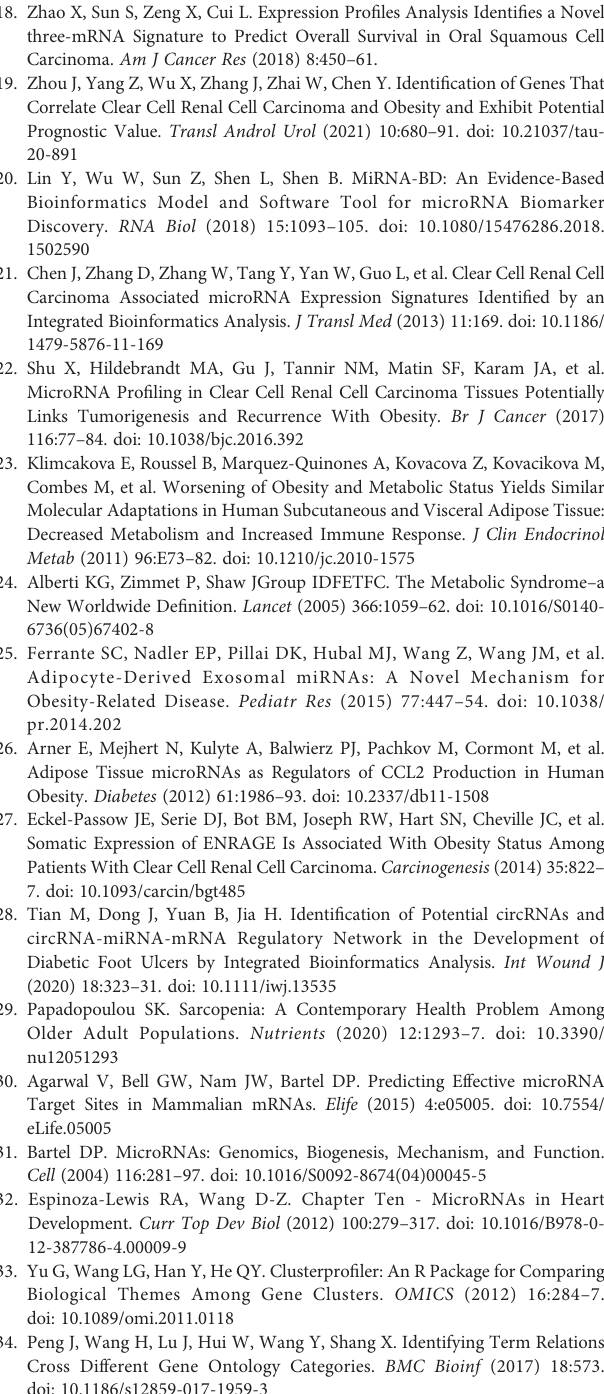
Supplementary Figure 1 | miRNA-mRNA networks of obesity in VAT (A) and SAT (B) .InthenetworkofVAT (A) ,87mRNAsand27miRNAswereincluded.Inthe network of SAT (B) , 101 mRNAs and 16 miRNAs were included. Blue and green ellipses represent mRNAs, and pink diamonds represent miRNAs. The color from dark to light respectively represents up- and down-regulated.